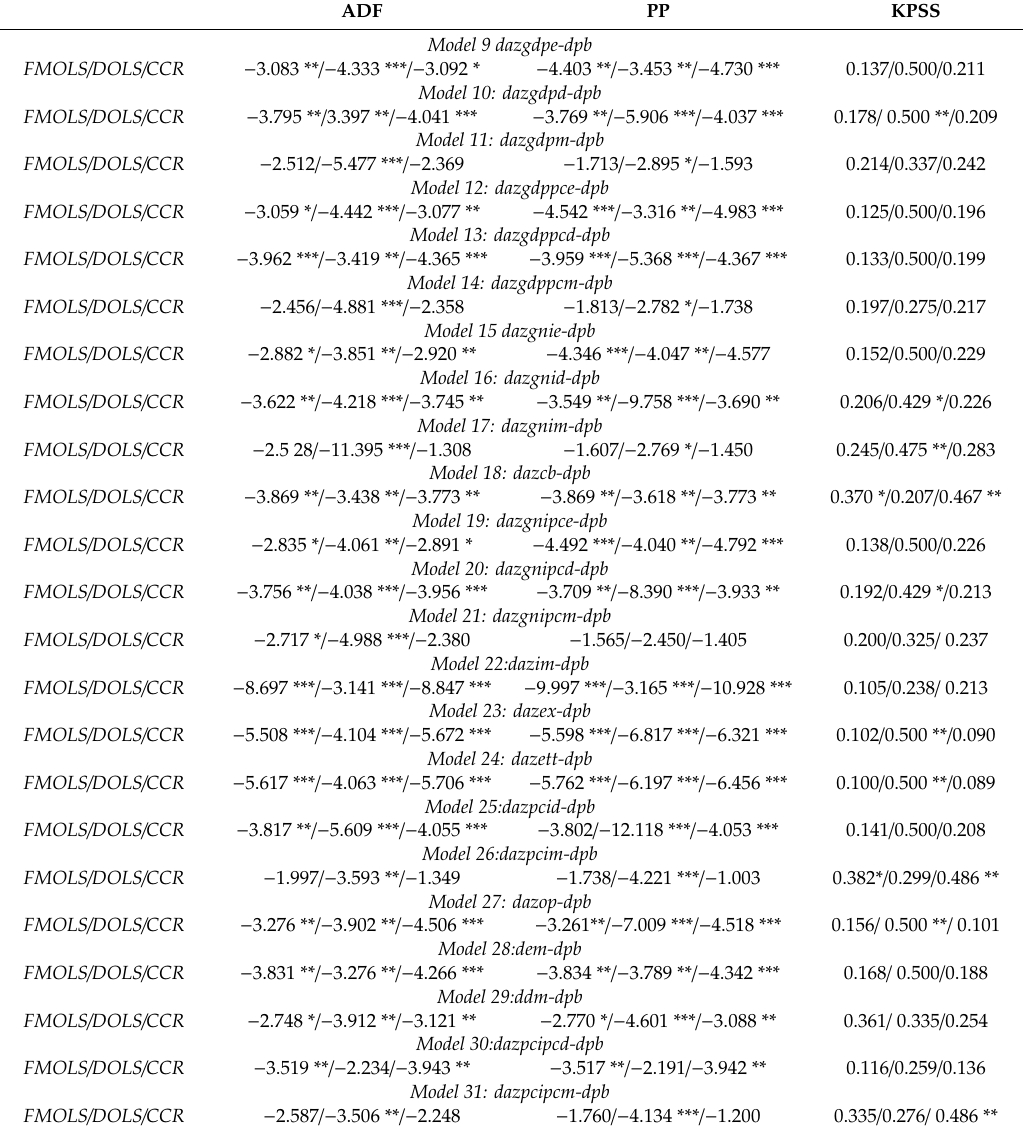
Table A22. AZ. The Unit Root test results